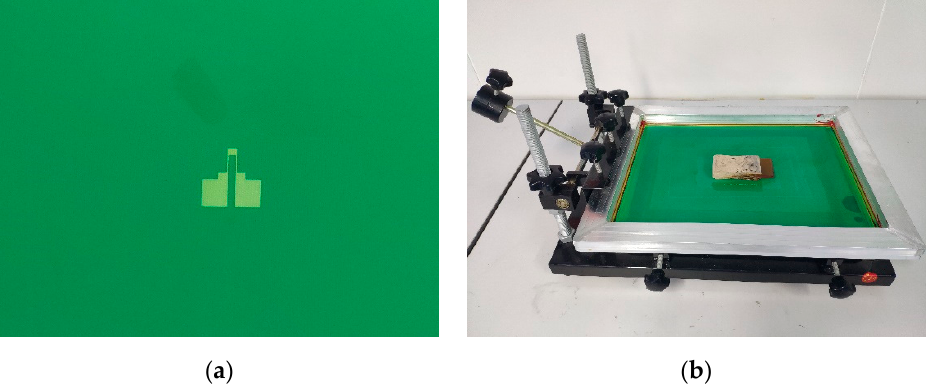
Figure 6. Photographs: ( a ) the screen mask with the pattern of the strain gauge on it; and ( b ) the manual screen-printing machine.